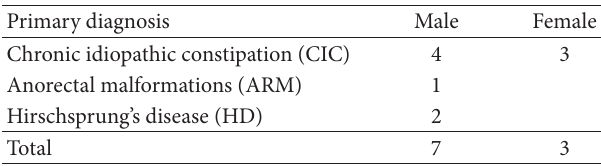
Table 2: Patient